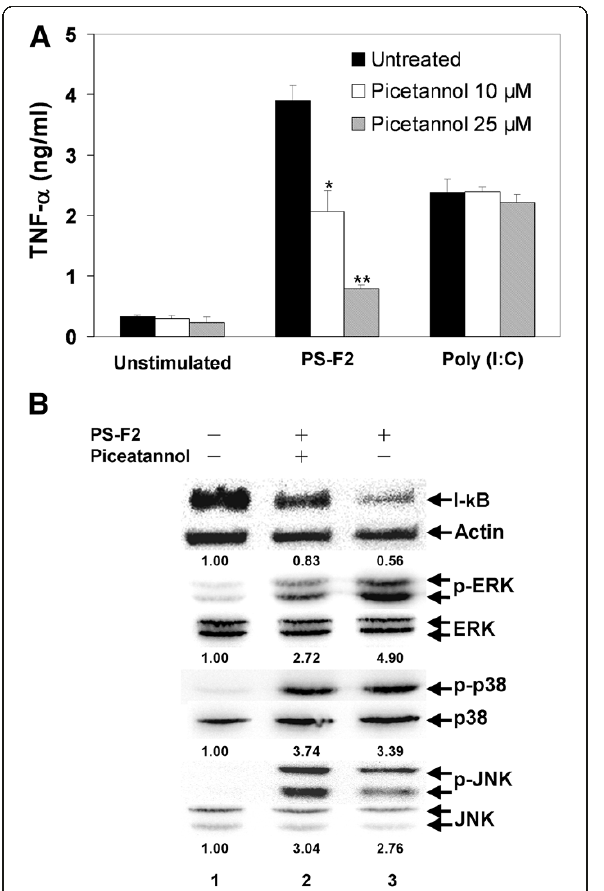
Figure 5 Role of Syk activation in PS-F2-stimulated TNF- α production in macrophages. ( A ) RAW264.7 cells were untreated or treated with piceatannol (10 and 25 μ M) for 1 h and stimulated with